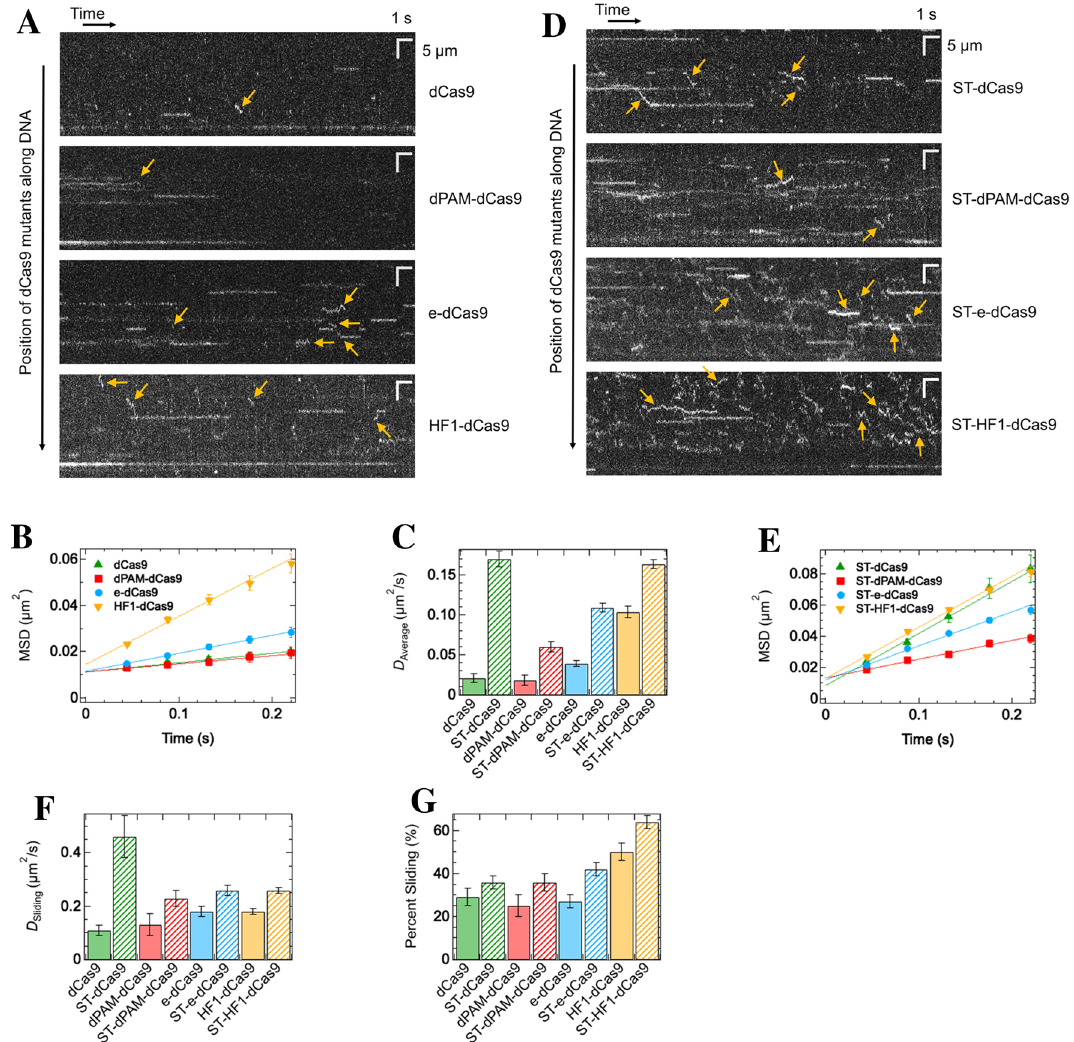
Figure 4. The basic tail of Nhp6A and mutations enhance the sliding of dCas9 in the presence of sgRNA. (A) Typical kymographs of dCas9 mutants. (B) MSD plots of all tracked molecules of dCas9 mutants ( N = 224 for dCas9, 153 for dPAM-dCas9, 403 for e-dCas9, and 519 for HF1-dCas9). Best-fit linear lines are shown ( R 2 = 0.87 for dCas9, 0.81 for dPAM-dCas9, 0.82 for e-dCas9, and 0.82 for HF1-dCas9). (C) Average diffusion coefficient of dCas9 mutants, including hybrids, along DNA. (D) Typical kymographs of dCas9 hybrid mutants. Typical sliding molecules are indicated by yellow arrows for ST-e-dCas9 and ST-HF1-dCas9 because of too many sliding events. (E) MSD plots of all tracked molecules of dCas9 hybrid mutants ( N = 209 for ST-dCas9, 342 for ST-dPAM-dCas9, 633 for ST-e-dCas9, and 1008 for ST-HF1-dCas9). The best-fit linear lines are shown ( R 2 = 0.74 for ST-dCas9, 0.85 for ST-dPAM-dCas9, 0.85 for ST-e-dCas9, and 0.83 for ST-HF1-dCas9). (F) Diffusion coefficient of the sliding mode for dCas9 mutants, including hybrids. (G) Sliding mode percentage of dCas9 mutants, including hybrids. In panels A and D, white lines or curves denote the traces of single molecules, and yellow arrows show sliding molecules (selected for ST-e-dCas9 and ST-HF1-dCas9 because of too many sliding events). In panels B and E, the errors denote standard The average D value of ST-dPAM-dCas9 was 3.3-fold higher than that of dPAM-dCas9 (Fig. 4C,E). ST-e-dCas9 and ST-HF1-dCas9 showed sliding with a short residence time in a higher fraction, as well as pausing with a long residence time (Fig. 4D). The average D values of ST-e-dCas9 and ST-HF1-dCas9 were enhanced 2.8-fold and 1.6-fold from that of e-dCas9 and HF1-dCas9, respectively (Fig. 4C,E). Altogether, the attachment of ST to dCas9 promoted the sliding of the dCas9 and sgRNA complexes along the DNA. To clarify the mechanism behind the enhanced sliding in the presence of sgRNA, the displacement distribu- tions were analyzed. In all mutants of dCas9 including hybrids, the displacement distributions were well described by the sum of the sliding and paused modes (Supplementary Fig. S6). The enhancement of the average D values was attributed to the increase in the D value or the percentage of the sliding mode (Fig. 4F,G, and Supplemen- tary Table S2). In particular, ST-dCas9 significantly enhanced the diffusion of the sliding mode, rather than the population of the sliding mode, as compared to dCas9. ST-HF1-dCas9 promoted both diffusion and population